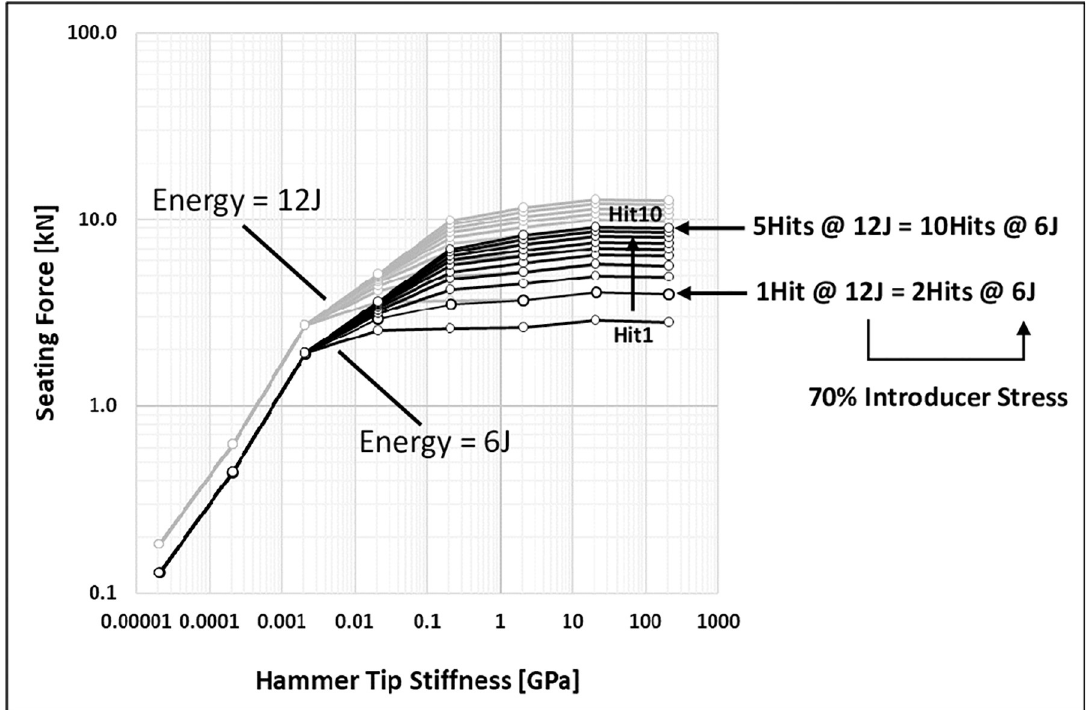
Fig 7. The implant seating force is the anchorage force achieved between implant and bone. It decreases with decreasing hammer tip stiffness and seating becomes less progressive with consecutive impactions (10 hits shown). Clinically measured impaction forces are achieved for a hammer tip stiffness of ~2GPa. Increasing the applied energy increases the seating for all hammer tip stiffnesses by the same